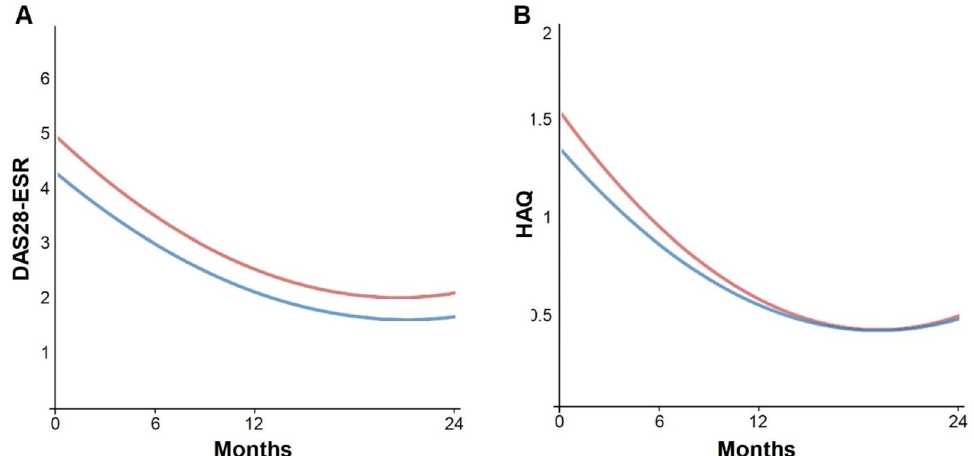
Figure 3. The overall estimated course of the DAS28-ESR and HAQ in the ACarPA + and ACarPA − patients considering all the available follow-up data. ( A ) The DAS28-ESR values were significantly different and the difference was constant, whereas the (B) HAQ was not different overall and showed a significant interaction with time. The ACarPA + patients are represented in red, whereas the ACarPA − patients are in